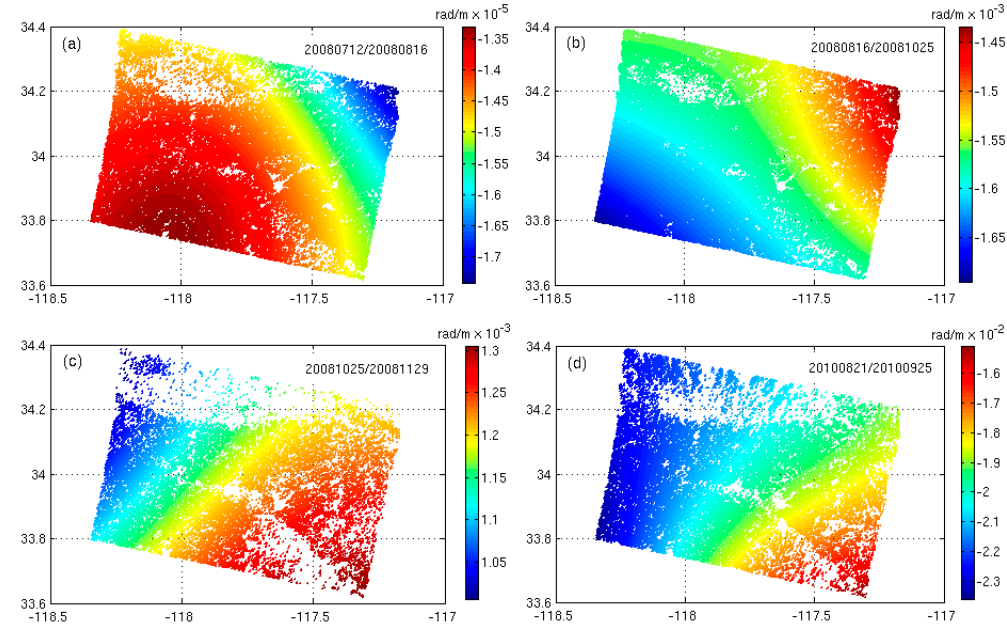
K estimated by the PLE method in California. ( a ) Figure 8. Examples of spatial maps of m Figure 8. Examples of spatial maps of K m estimated by the PLE method in California. ( a ) Interferogram Interferogram 20080712/20080816. ( b ) Interferogram 20080816/20081025. ( c ) Interferogram 20080712/20080816. ( b ) Interferogram 20080816/20081025. ( c ) Interferogram 20081025/20081129. 20081025/20081129. ( d ) Interferogram 20100821/20100925. ( d ) Interferogram